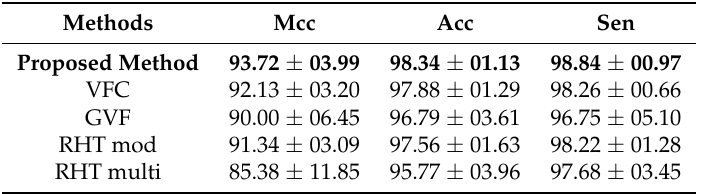
Table 3. Comparison of the method proposed by this study between models in the literature; VFC, GVF, RHT mod, and RHT multi.